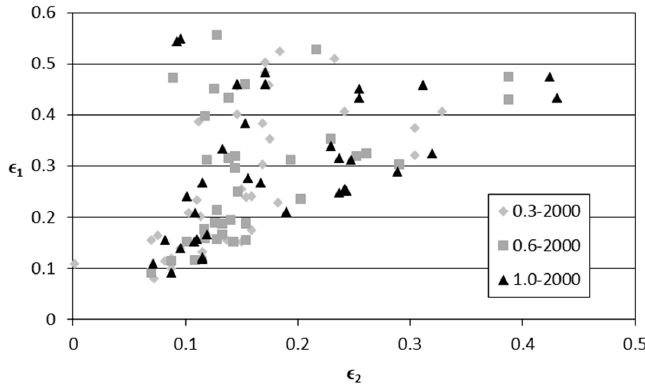
Figure 11. Format limit diagram for molds (2000 mm/min).